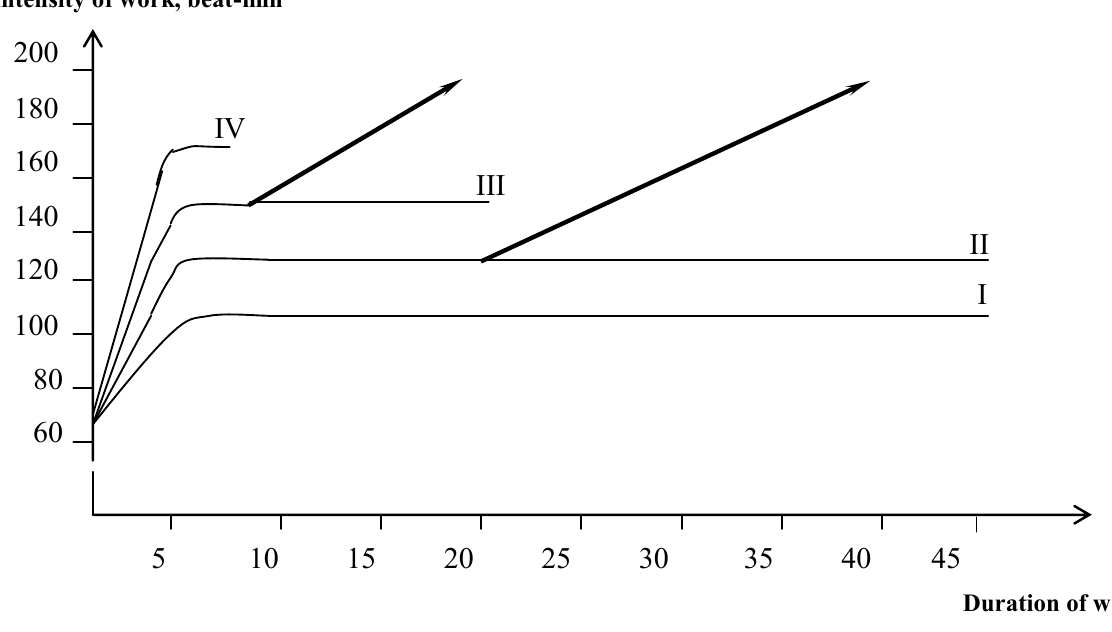
Fig. 1. Relation between the training effect of load and its intensity and duration